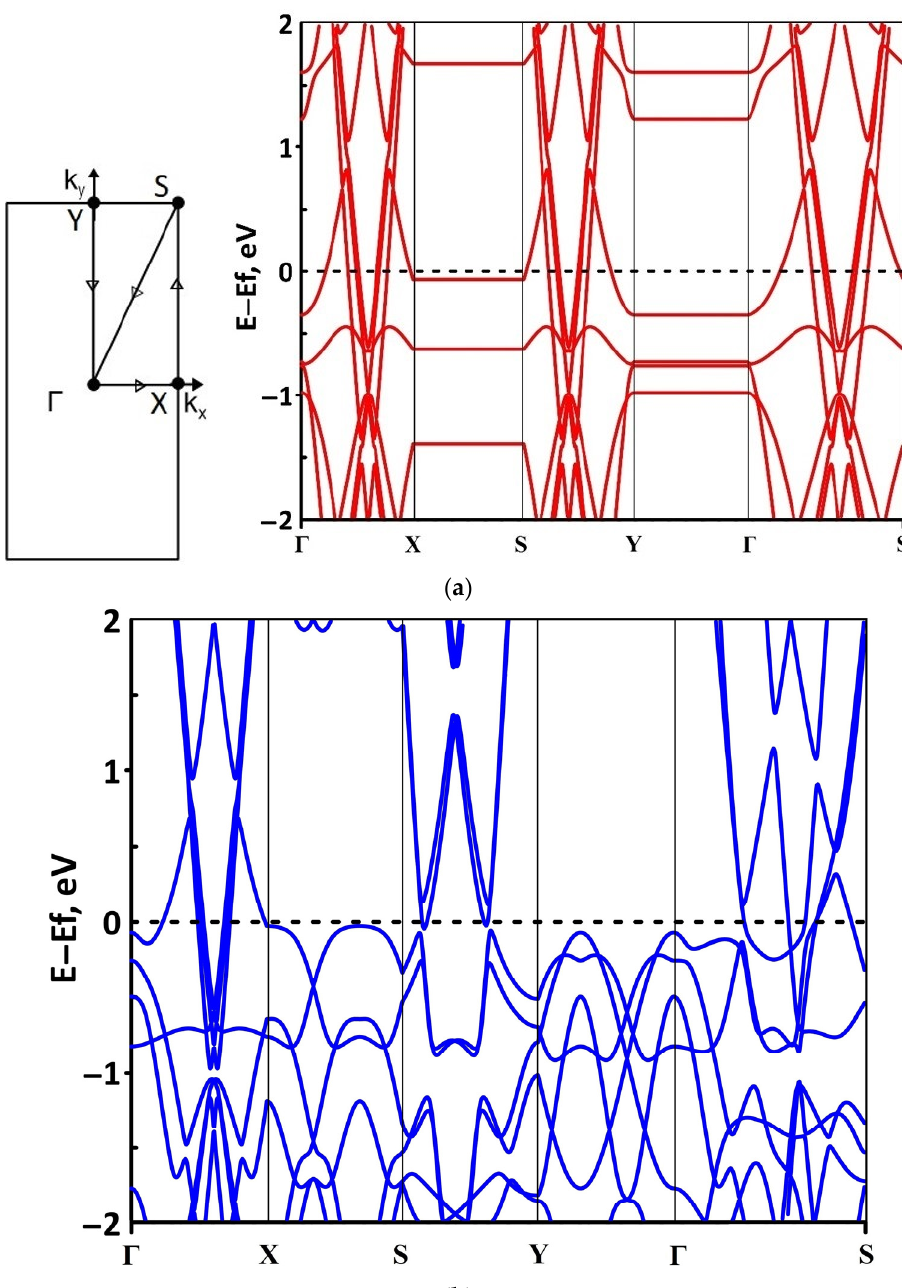
Figure 2. Band diagrams near the Fermi level (shifted to 0 eV) of borophene/GaN ( a ) and borophene/ZnO ( b ) van der Waals heterostructures.